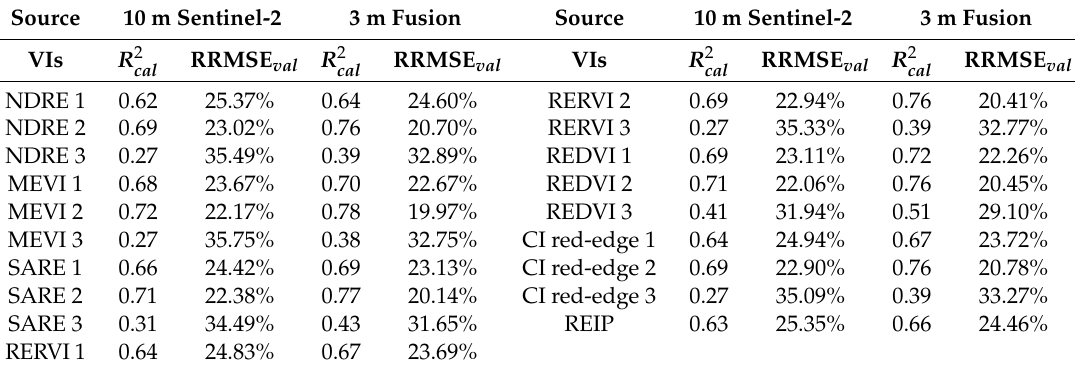
Table 6. Comparison of R 2 and RRMSE val values between RE-VIs and LAI estimates derived from cal Planet, Sentinel-2, and fused image.